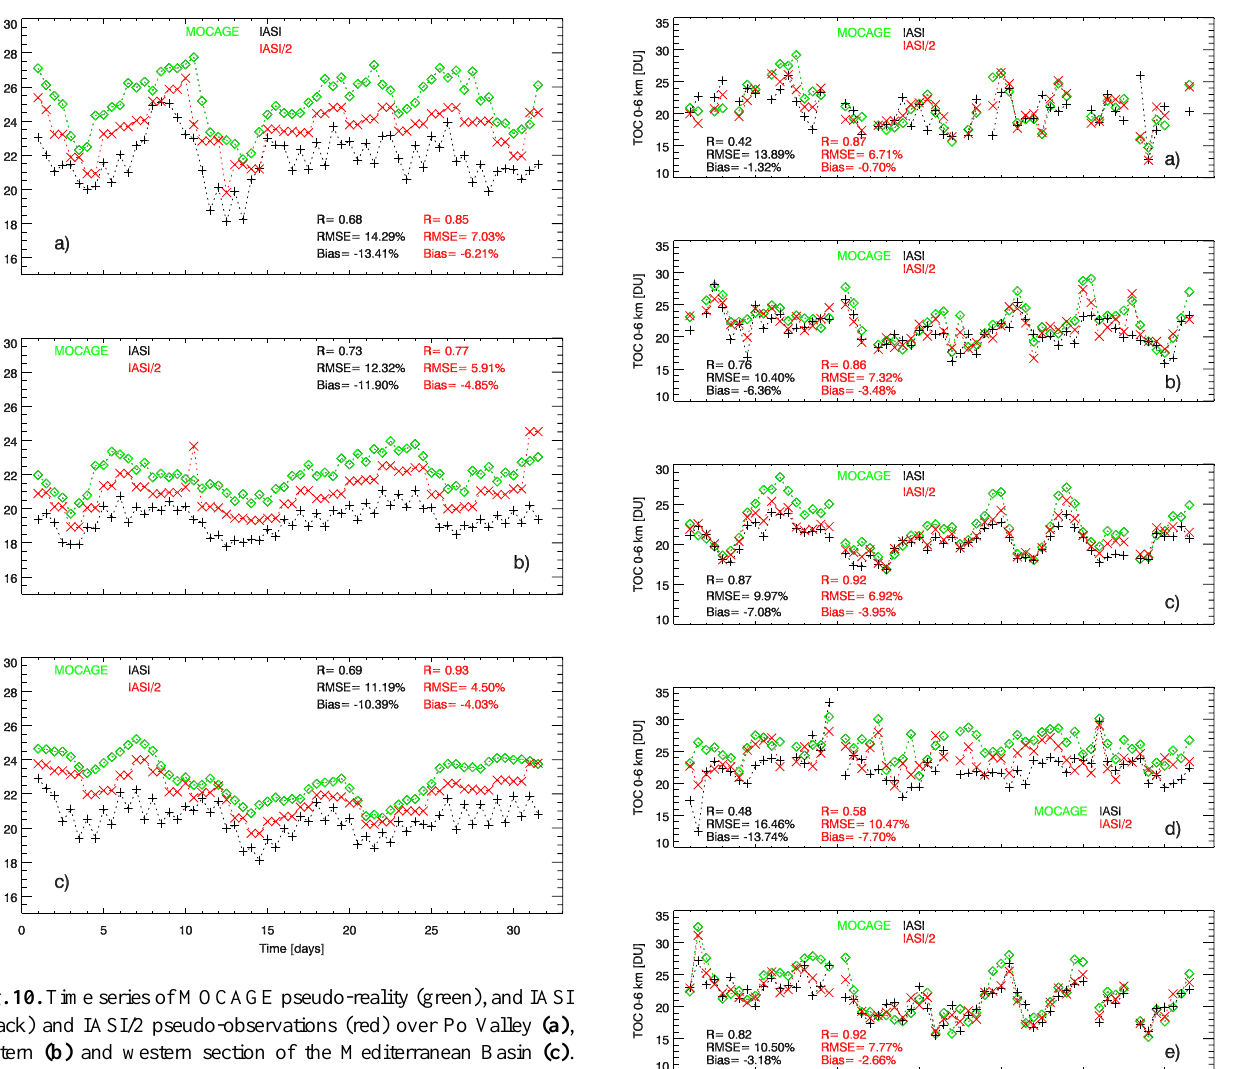
Fig. 13. The added value of IASI/2 may be related to a